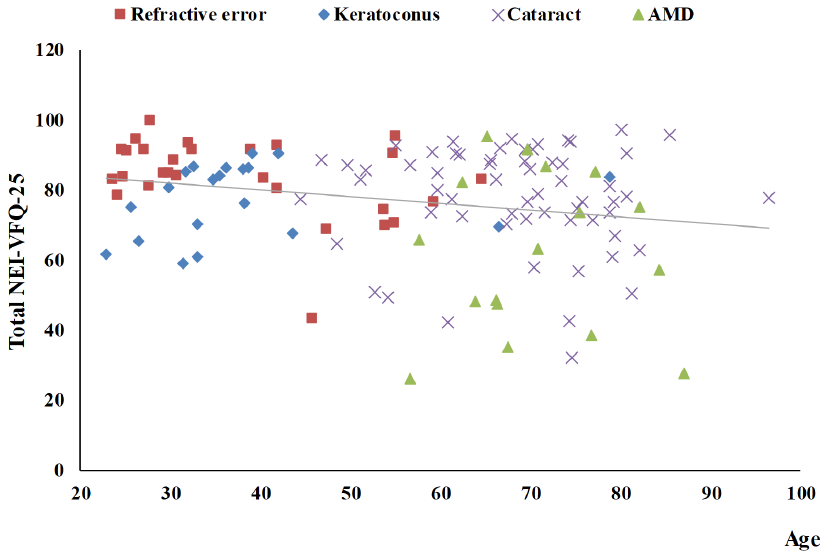
represent a significant difference between groups, and the same letters represent no difference be- tween groups. AMD: age-related macular degeneration. NEI-VFQ-25: National Eye Institute Visual Function Questionnaire 25.